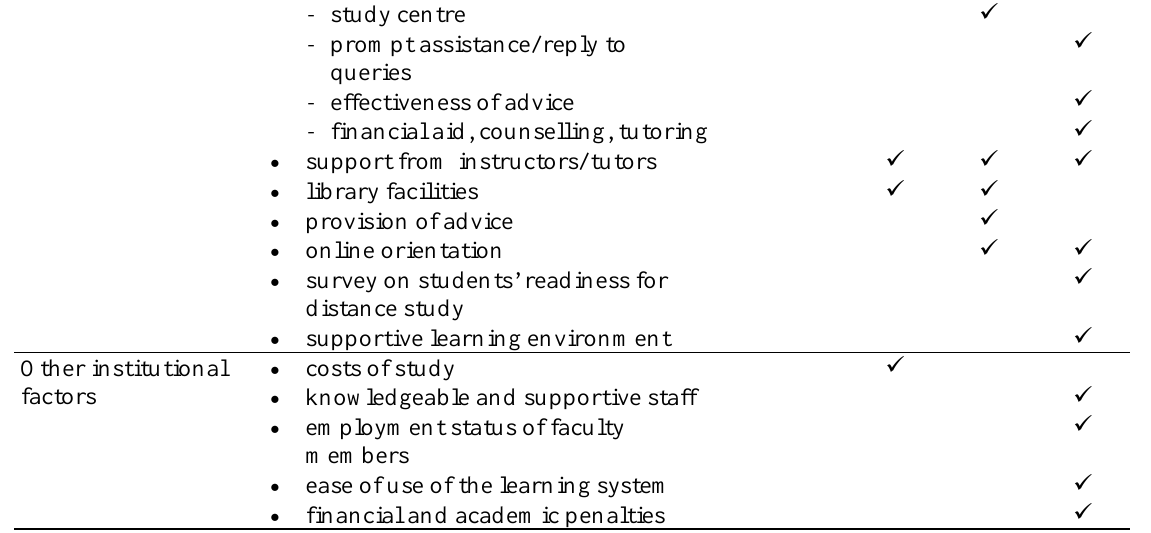
Environmental Factors Affecting Student Persistence